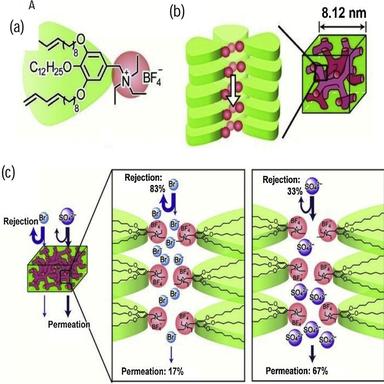
(a) Diagram of graphene sheets in liquida showing possible corrugation; (b) Chemically converted graphene (CCG) sheets imaged by tapping mode AFM in water; scale bar: 250 nm. The arrows highlight the most corrugated sheets. (c) UV–vis absorbance spectra of DY aqueous solutions showing the higest rejection by the 90 °C reduced membrane, increasing the concentration of the top liquid as the time passes.